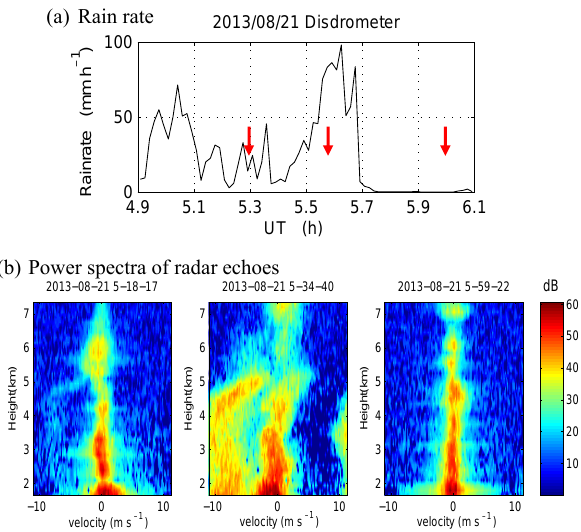
Figure 6. (a) Rain rate measured by the disdrometer located near Figure 5: (a) Rain rate measured by the disdrometer located near the radar site. (b) the radar site. (b) Three typical power spectra of radar echoes at the Three typical power spectra of radar echoes at the times indicated sequentially by the times indicated sequentially by the red arrows in (a) red arrows in (a).